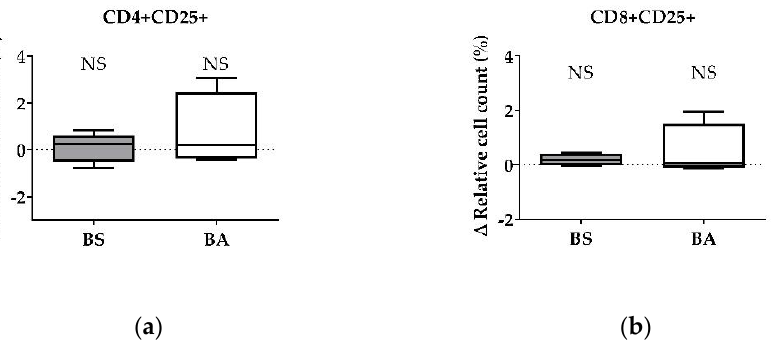
Figure 6. Influence of UV-inactivated B. subtilis DSM 32315 (grey) and B. amyloliquefaciens CECT 5940 (white) on the activation of T cells. Isolated PBMCs were treated with either UV-inactivated BA or BS, or left untreated (negative control). After treatment for 24 h, immune cells were stained with monoclonal antibodies. The relative cell count was related to untreated controls. DAPI was used as a viability marker. ( a ) CD4+CD25+ activated T-helper cells and ( b ) CD8+CD25+ activated cytotoxic T cells relative to the vital PBMC cell count. 20,000 vital PBMCs were recorded on a BD FACSCanto II flow cytometer. Data represent 4 (BA) or 5 (BS) biological replicates. Results are presented as box and whisker plots showing the median, with a 25–75 percentile range as the box and min to max as the whiskers. Significance is shown as NS: not